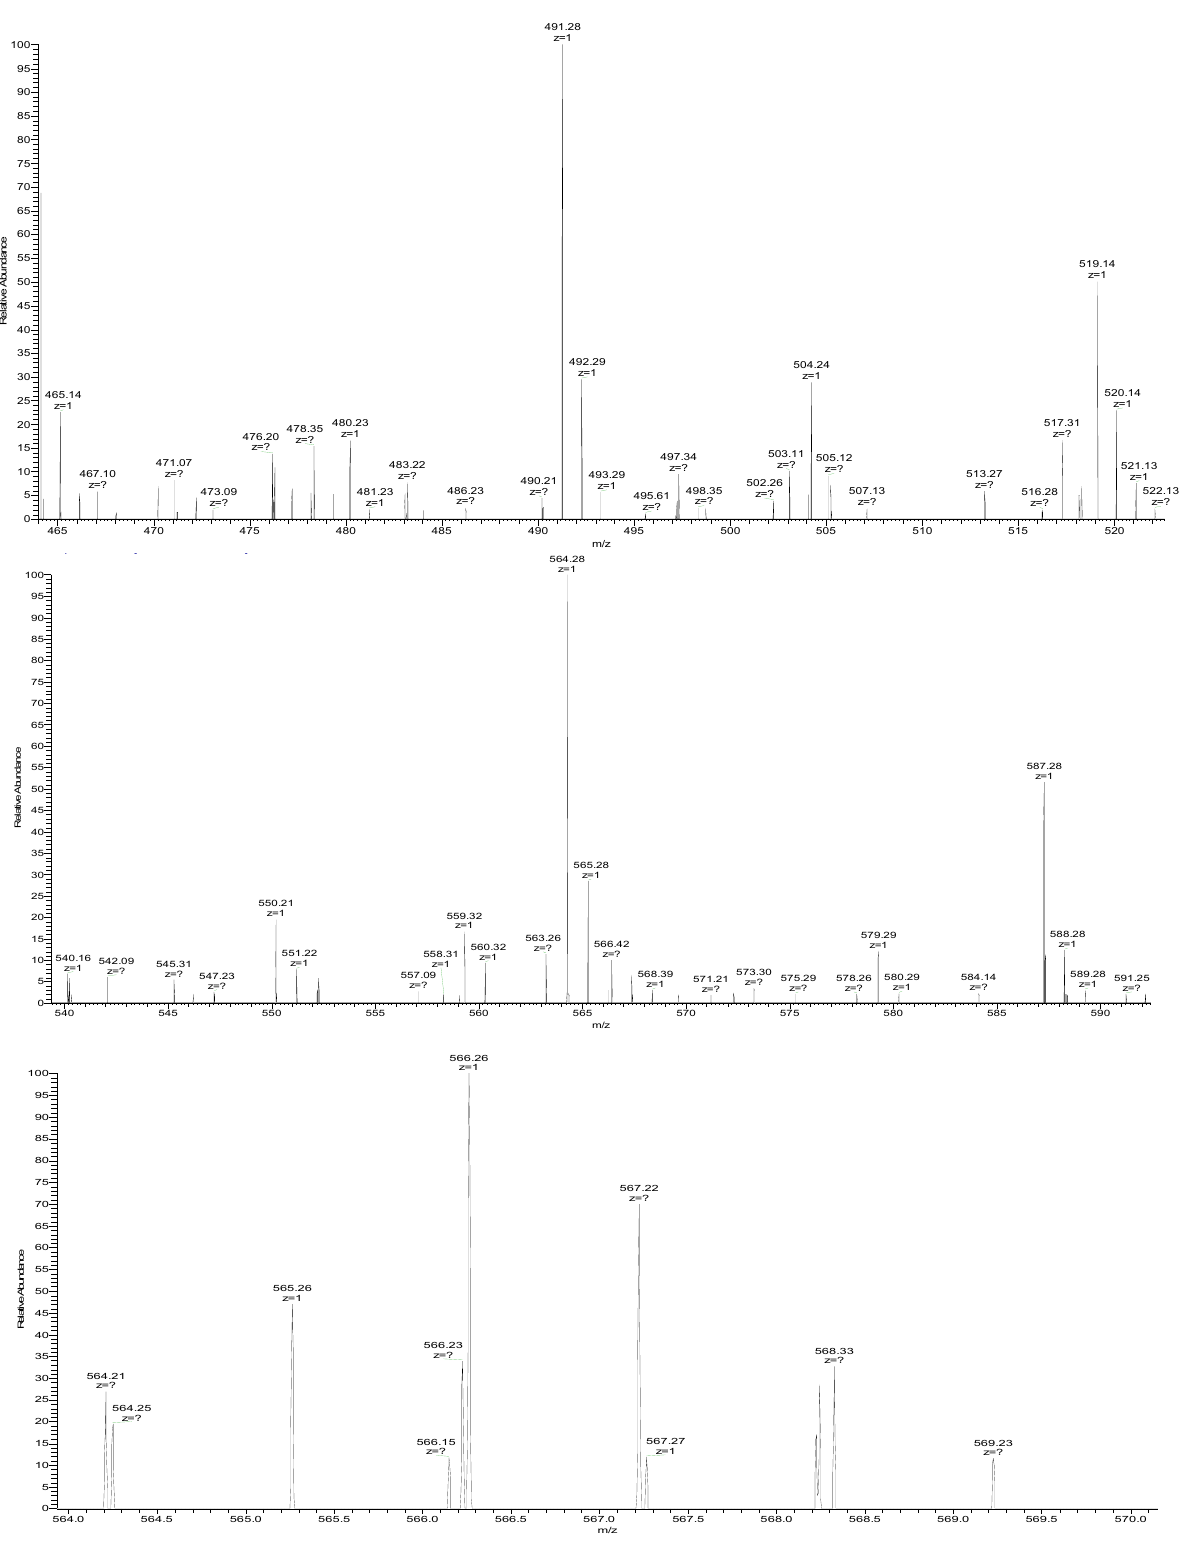
Figure 12. Primary mass spectra of three novel ACE inhibitory peptides .